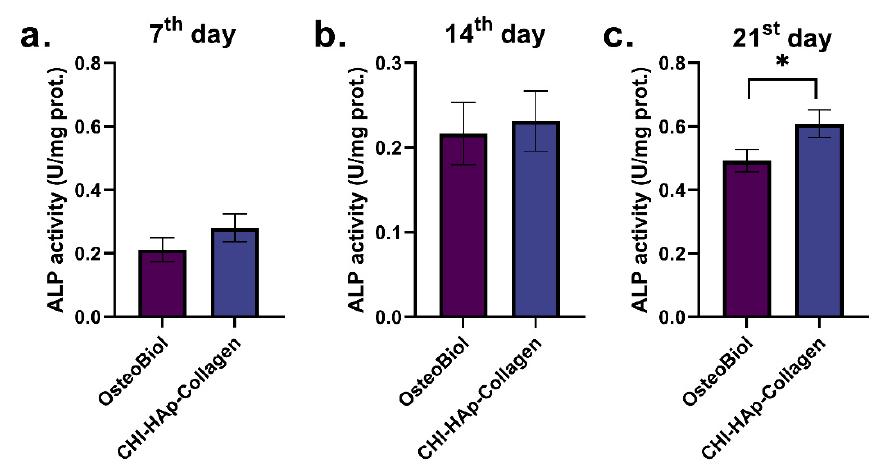
Figure 4. ALP activity of DPCSs during ( a ) seven, ( b ) fourteen, and ( c ) twenty-one days of osteogenic differentiation. OsteoBiol—collagen membrane; CHI–HAp–collagen—collagen membrane with addition of nano-hydroxyapatite and chitosan; * p < 0.05.